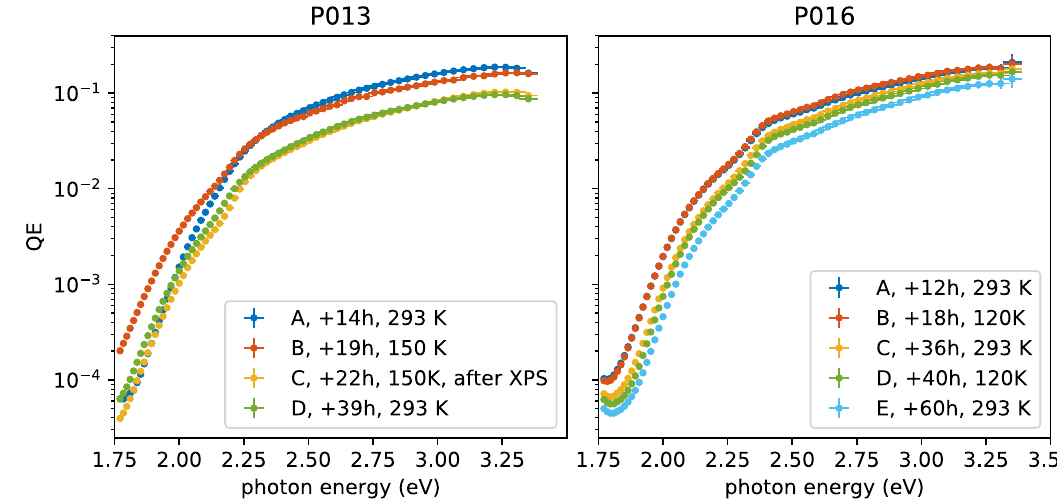
FIG. 4. Spectral response as obtained during the cryogenic cooling experiments with P013 and P016 with a vacuum pressure in the low 10 − 10 mbar regime. P013 was cooled down to 150 K while P016 was cooled repeatedly to 120 K. Both experiments were performed in the photocathode preparation chamber and cooling of the sample stage with liquid nitrogen. The age of each sample is indicated relative to the QE measurements presented in Table I.